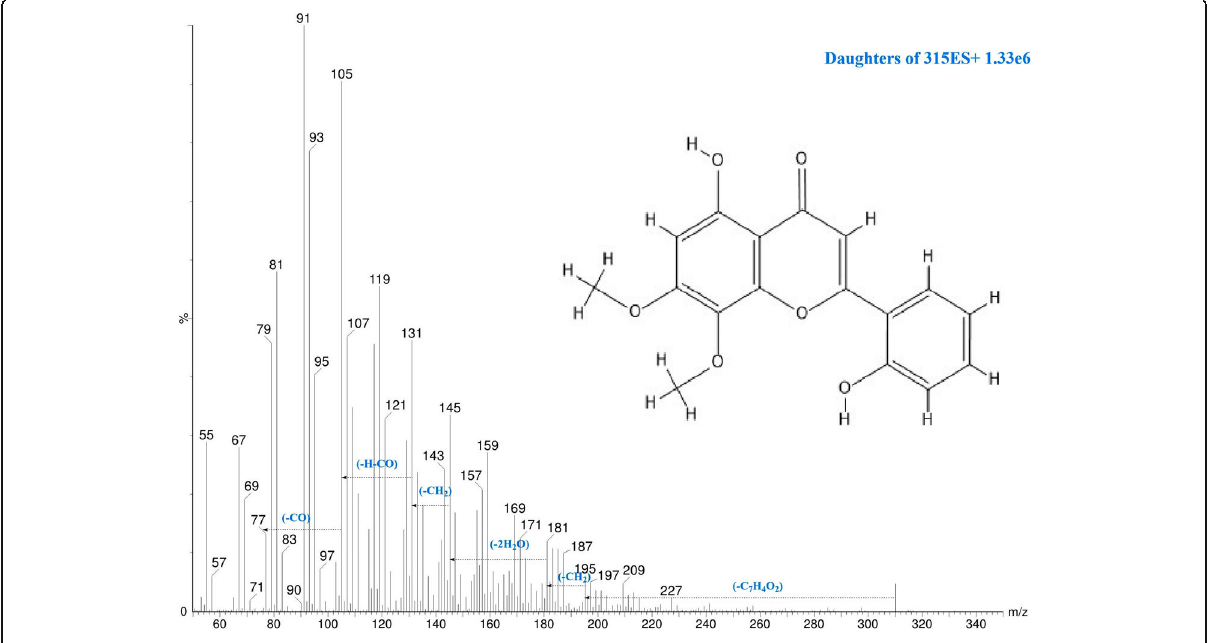
Fig. 11 Fragmentation pathway of Skullcapflavone